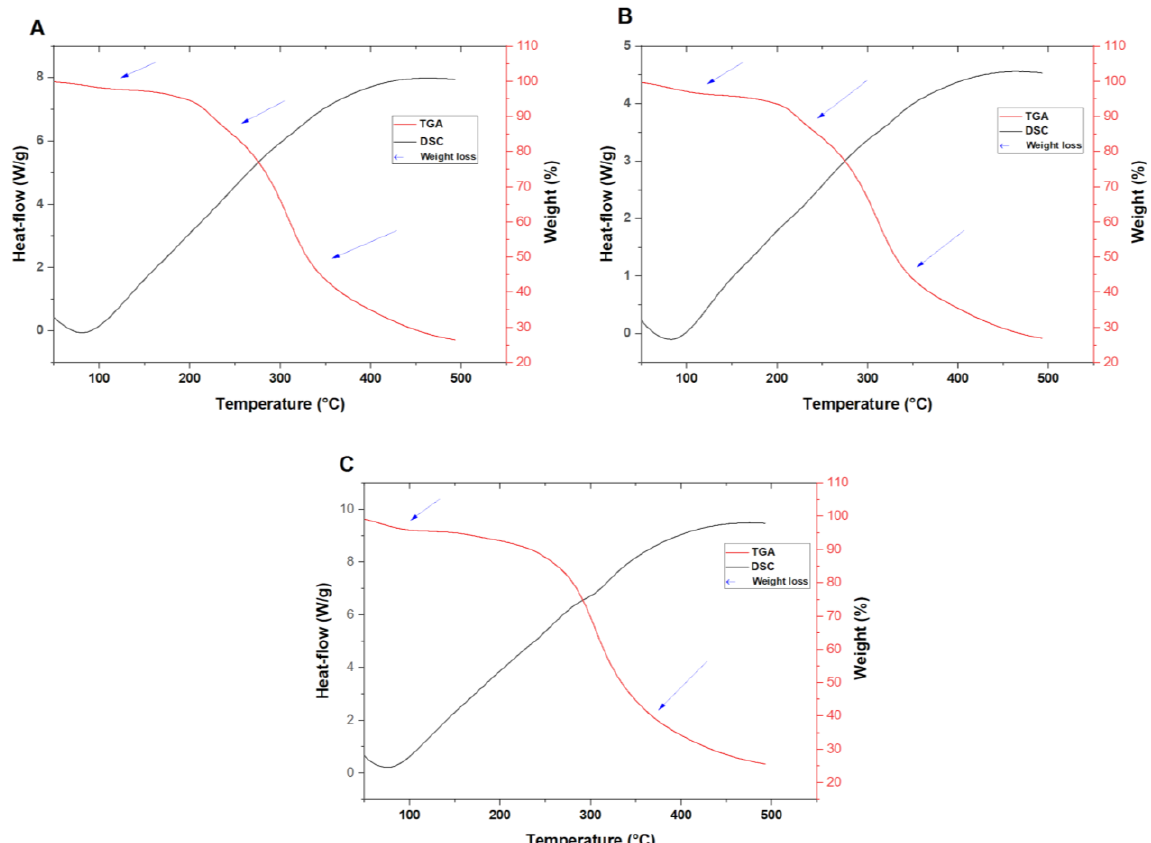
Figure 4. TGA-DSC curves of microparticles WPI + LA + CT ( A ), MD + LA + CT ( B ), WPI + MD + LA + CT ( C ). WPI + LA + CT: Whey protein isolate + L. acidophilus + Charantin; MD + LA + CT: Maltodextrin + L. acidophilus + Charantin; WPI + MD + LA + CT: Whey protein isolate + Maltodextrin + L. acidophilus + Charantin .